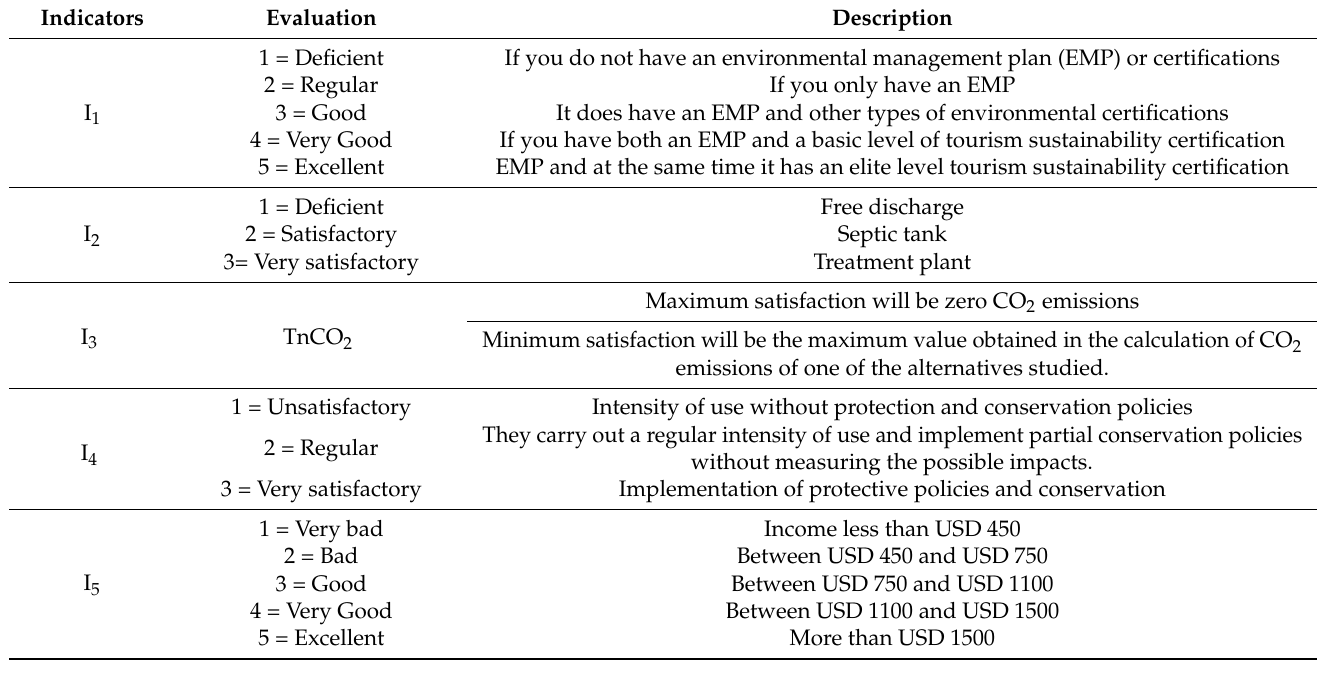
Table A1. Criteria and scales to estimate for each